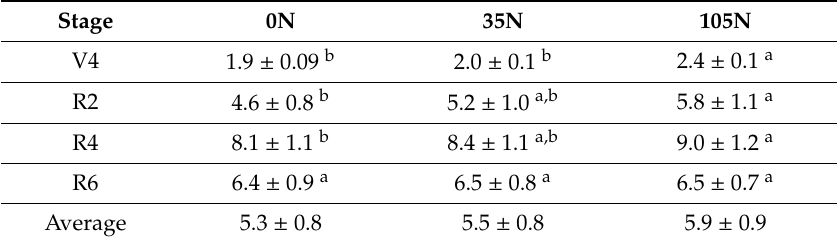
Table 7. The e ff ect of di ff erent fertilization rates on LAI at di ff erent stages of soybean’s (cv. Pannonia Kincse) life cycle, averaged among 2017, 2018, and 2019 in Debrecen, Hungary.